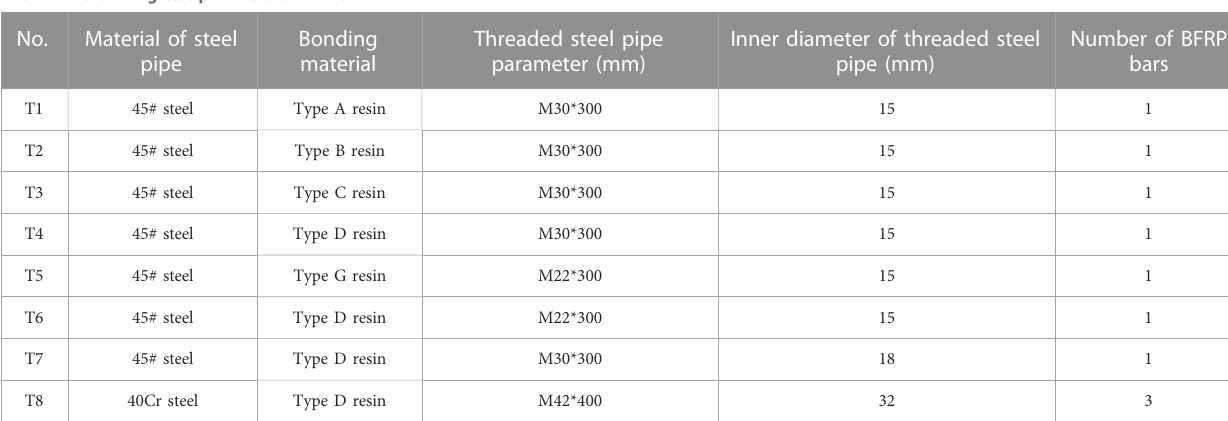
TABLE 4 Tensioning test parameters for the TSAS.